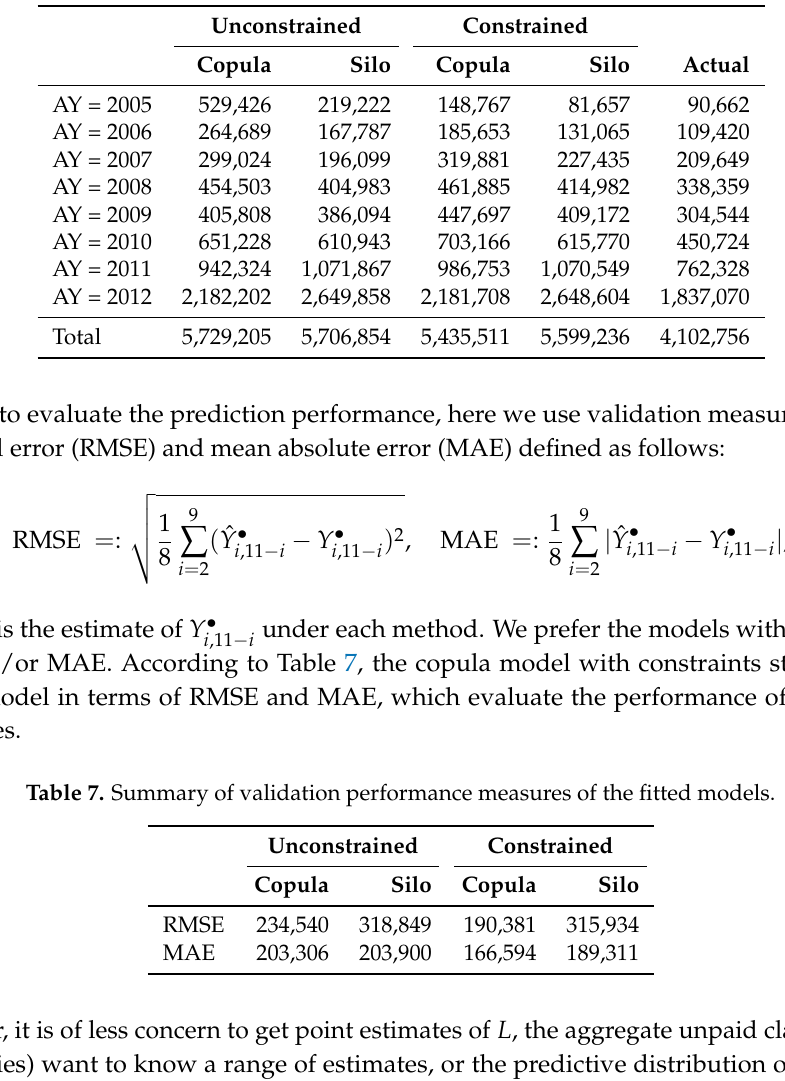
Table 6. Summary of unpaid claims prediction with the fitted models.